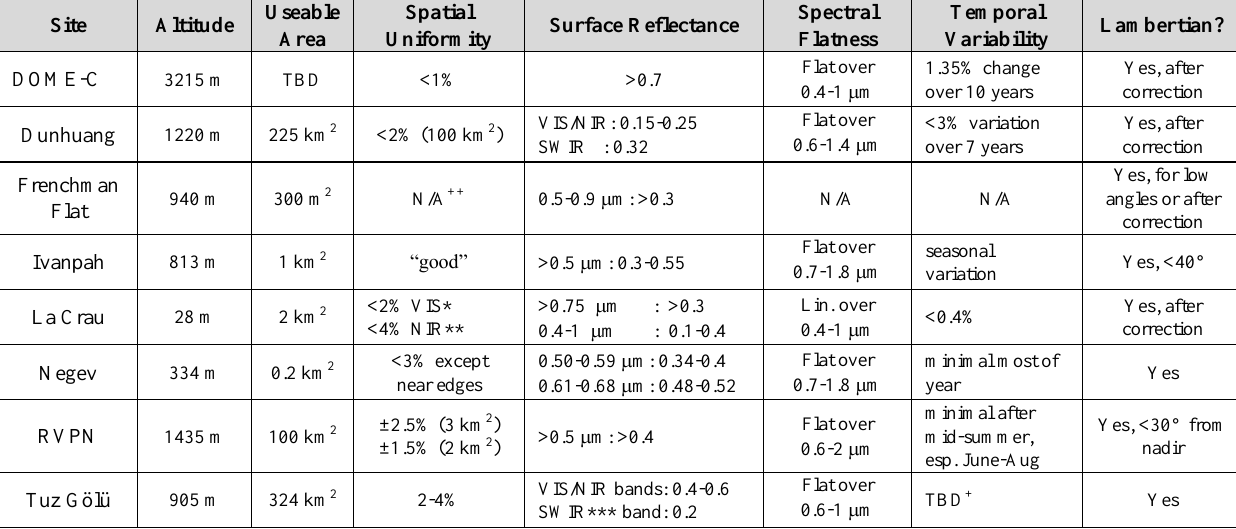
Table 1. Summary of LANDNET Site Characteristics (Compiled from References) Useable Site Altitude